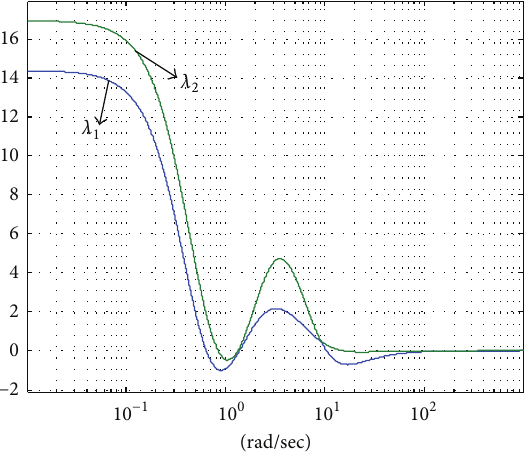
Figure 7: Eigenvalues of [𝐺 𝑝3 (𝑗𝜔) + 𝐺 ∗ 𝑝3 (𝑗𝜔)] (Case 3 ).